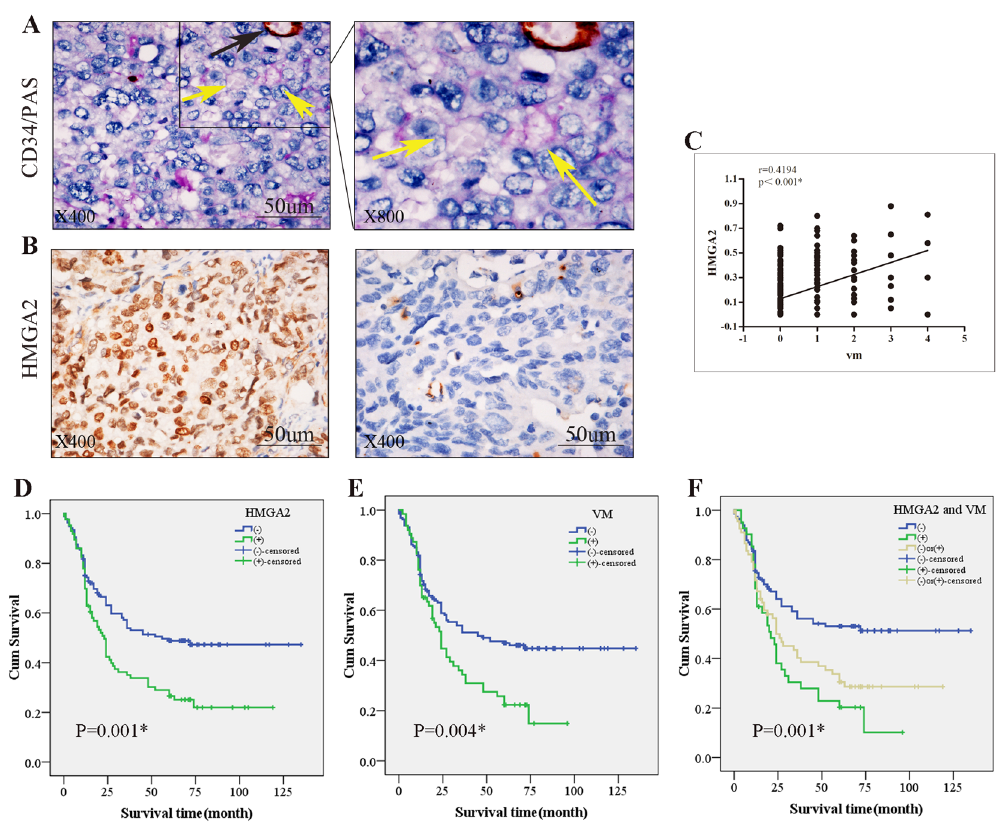
Figure 1. The correlation of HMGA2 expression with VM in clinical samples. ( A ) Phenomena of VM (yellow arrow, CD34-negative and PAS positive) and EDV (black arrow, CD34-positive and PAS-positive) in gastric carcinoma specimens; ( B ) IHC staining of HMGA2, the left for positive and the right for negative nuclear expression ( × 400, bar 50 um); ( C ) Quantum analysis of the correlation of HMGA2 with VM. A positive correlation between HMGA2 and VM using the Pearson correlation was observed ( * P < 0.001, r = 0.4194) ( D , E , F ) Kaplan-Meier survival curve demonstrated that HMGA2 expression ( D ), VM ( E ), and a combination of HMGA2 expression and VM density ( F ) are significantly related to poor prognosis. (Log Rank χ 2 = 10.693, P = 0.001; Log Rank χ 2 = 8.413, P = 0.004; Log Rank χ 2 = 14.494, P =